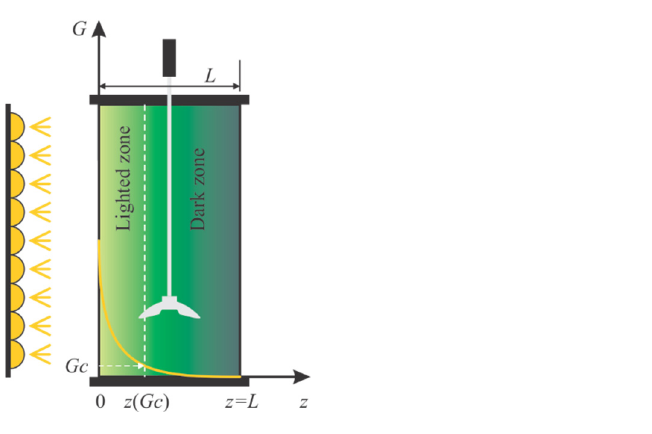
Figure 1. Schematic representation of light attenuation inside the photobioreactor.